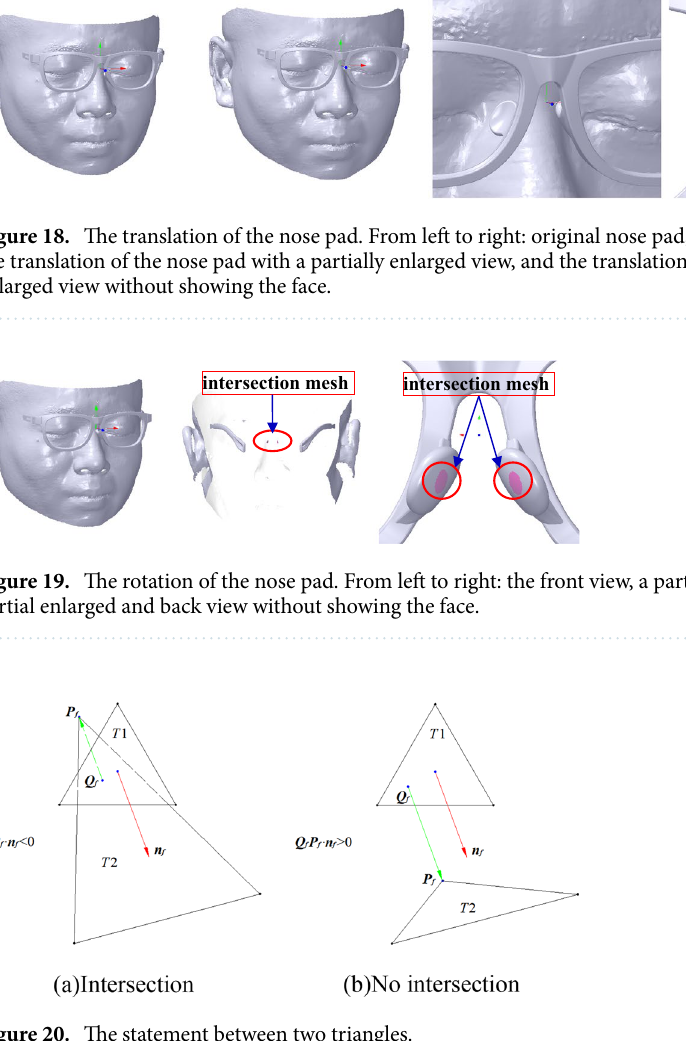
Figure 20. The statement between two